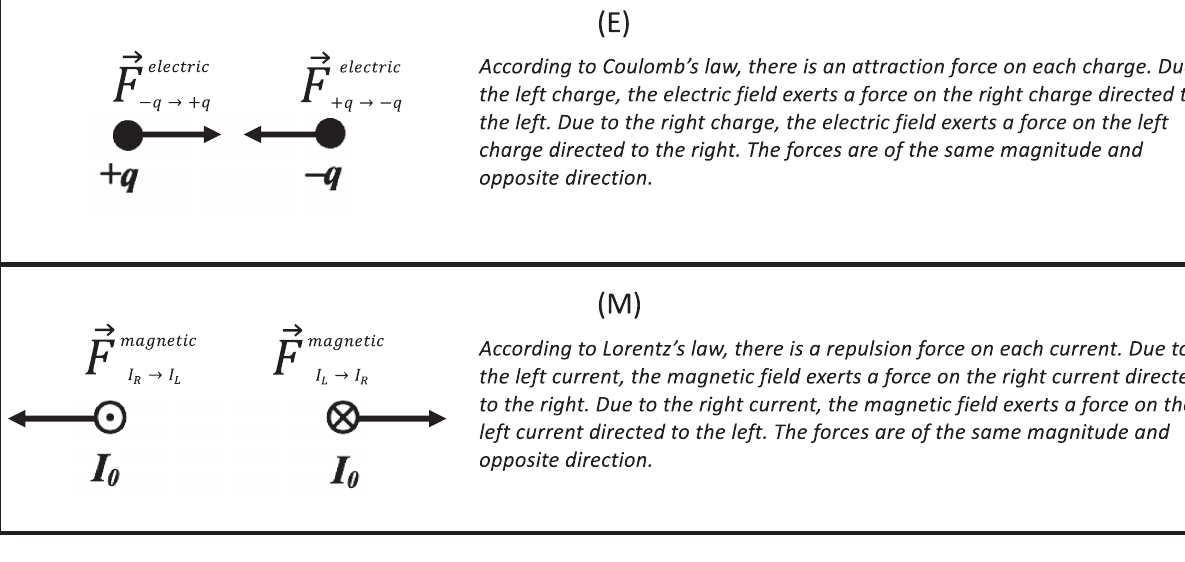
FIG. 4. Expected answer for the pair No. 2 of parallel items. On the top, the expected diagram and reasoning for the electricity version ( E ); on the bottom, the expected diagram and reasoning for the magnetism version ( M ).